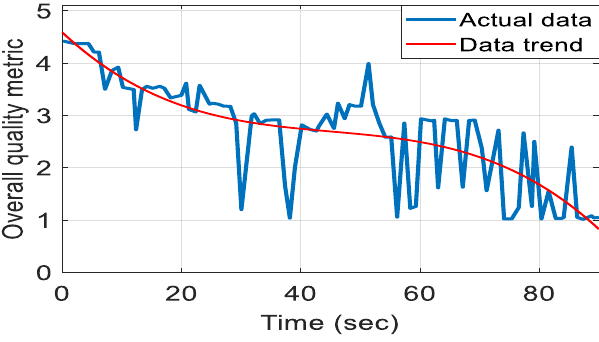
Figure 16. Evaluation of video quality transmission by FIS3.